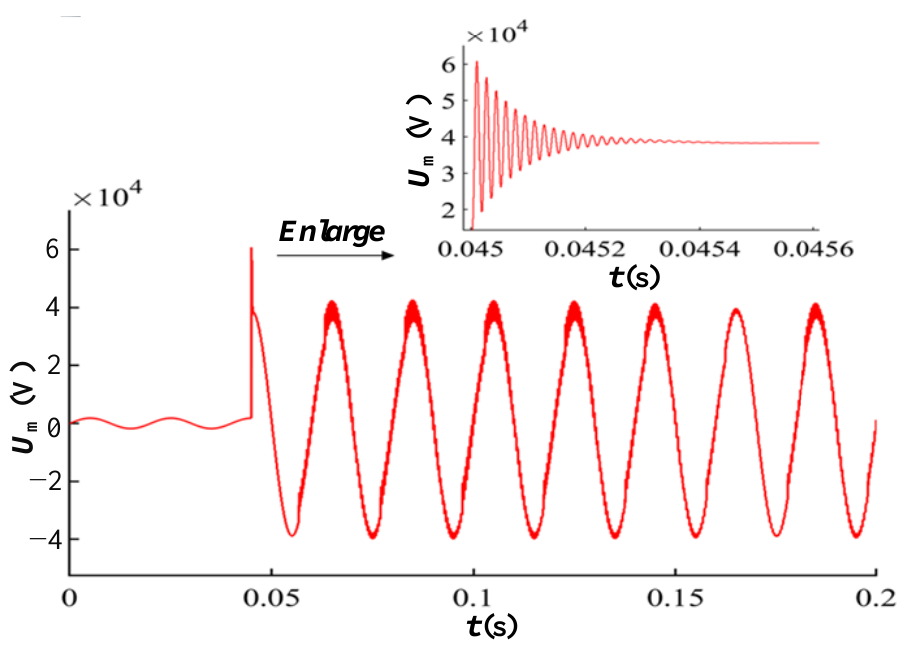
Figure 8. Overvoltage transient process.